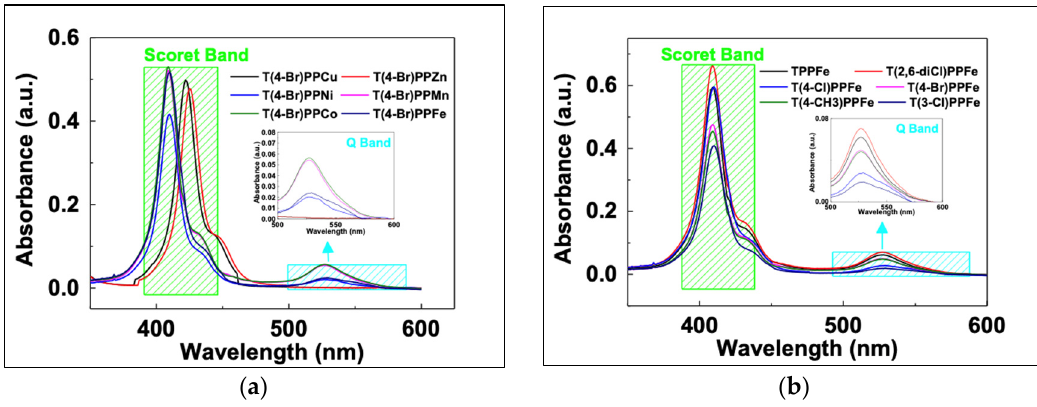
Figure 1. UV-Vis absorption spectra of metalloporphyrins ( a , b ).